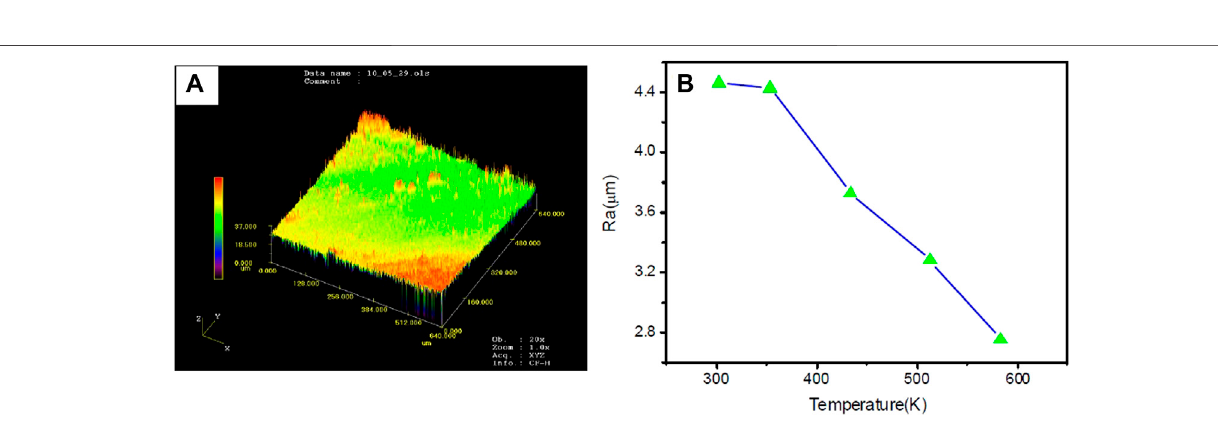
Frontiers in Materials |